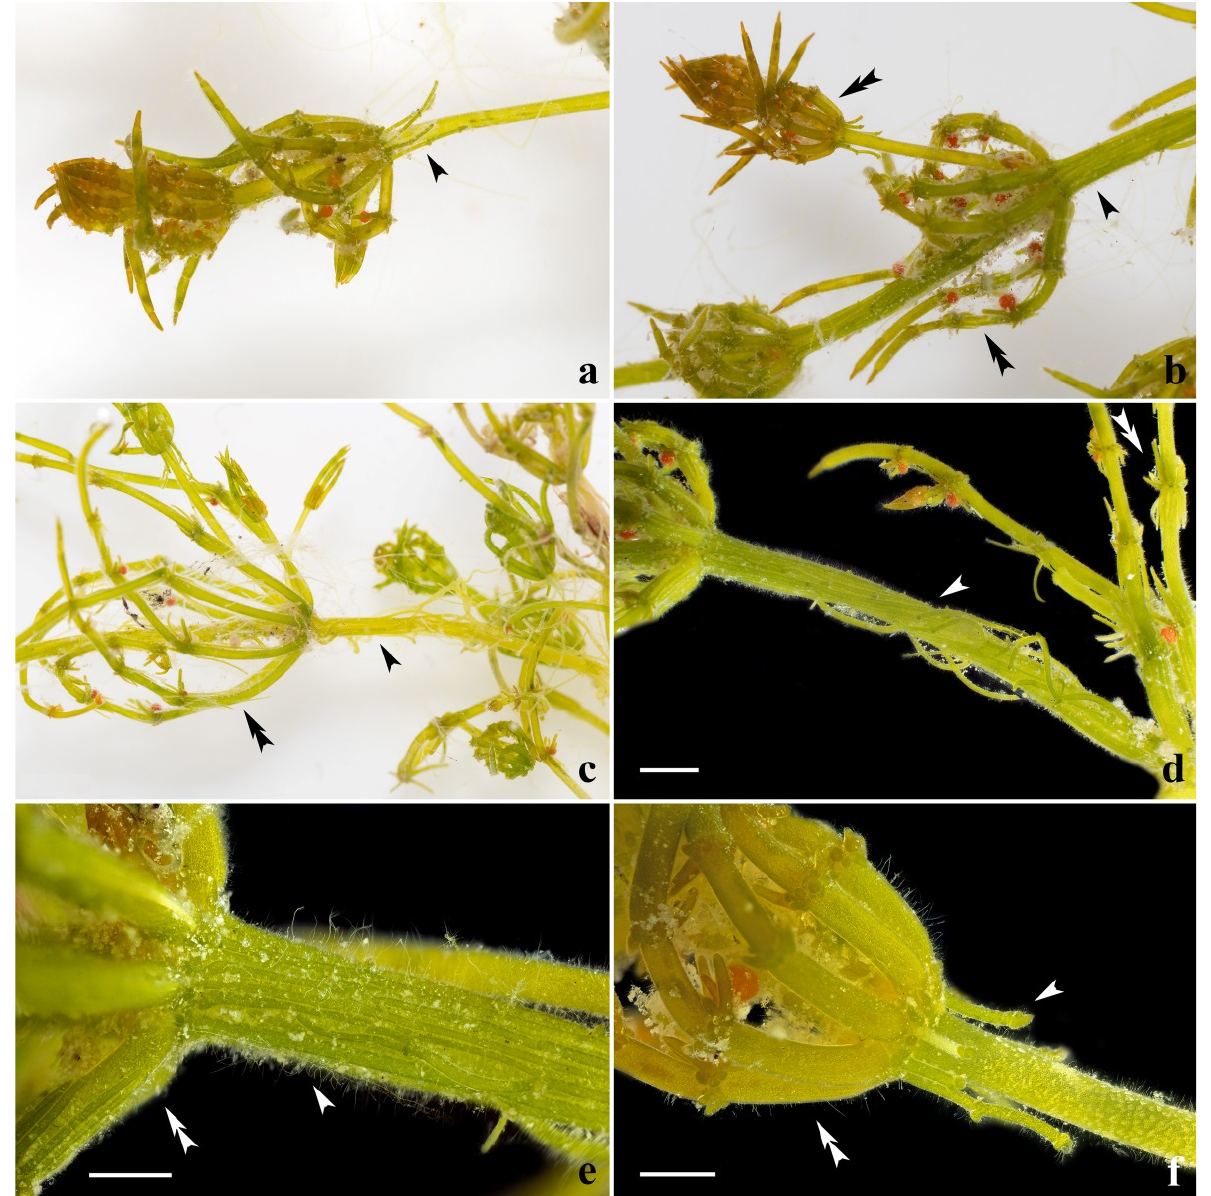
Figure 4. Chara dissoluta from minerotrophic wetland in Slovakia: ( a , b )—apical and subapical parts showing short ecorticate undifferentiated segments of branchlets; ( c )—middle part with arcuate branchlets and stem cortex peeling of the stem; ( d )—stem cortex consisting of long primary tubes and short secondary tubes with empty spaces between them; ( e )—base of branchlet whorl showing short stipulodes and cortication pattern of basal branchlet segment and stem; ( f )—base of branchlet whorl with initials of branchlet cortex and short primary tubes of stem cortex peeling of the stem. Different length of tubes of stem cortex (arrowhead) and branchlet cortex (double arrowheads) is notable. Scale: ( d , f )—1 mm, ( e )—0.5 mm. Photos by F. Bedn á